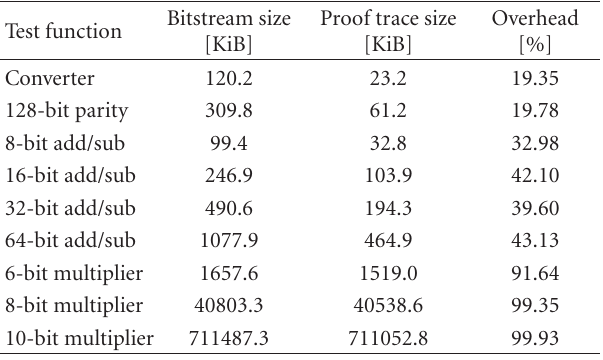
Table 6: Size measurements for the bitstream and proof trace. Test